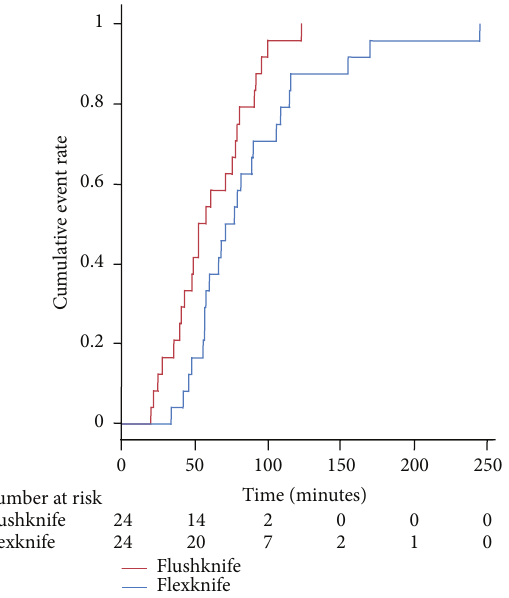
Figure 3: Empirical distribution function plot for operation time using each endo-knife. The hazard ratio for completion of the procedure between two groups was 0.53 (95% CI: 0.29–0.97) and was significant ( 𝑃 = 0.04